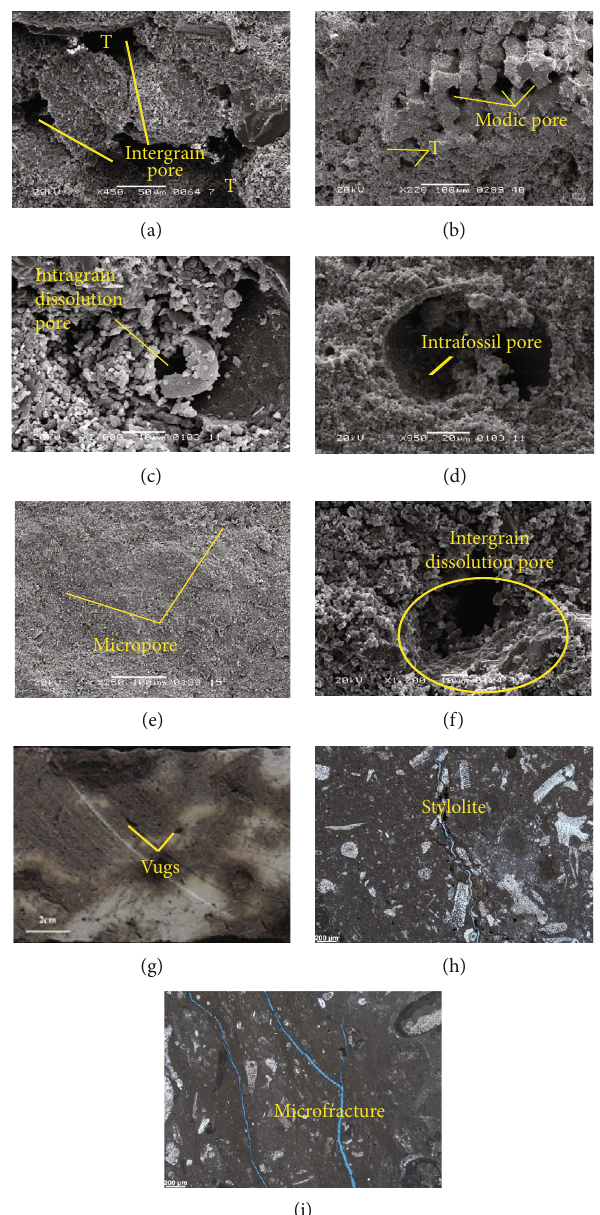
Figure 3: Reservoir pore systems of the K formation: (a) intergrain pore (RT1, H1, 2663.58m); (b) moldic pore (RT2, H11, 2624.56m); (c) intragrain dissolution pore (RT3, H2, 2621.25m); (d) intrafossil pore (RT4, B1, 2642.51m); (e) micropore (RT5, H2, 2605.42m); (f) intergrain dissolution pore (RT1, H1, 2674.37 m); (g) vugs (RT2, H11, 2648.28m ~ 2648.41m); (h) stylolite (RT6, H2, 2600.31m); (i) microfracture (RT5, H2, 2599.55